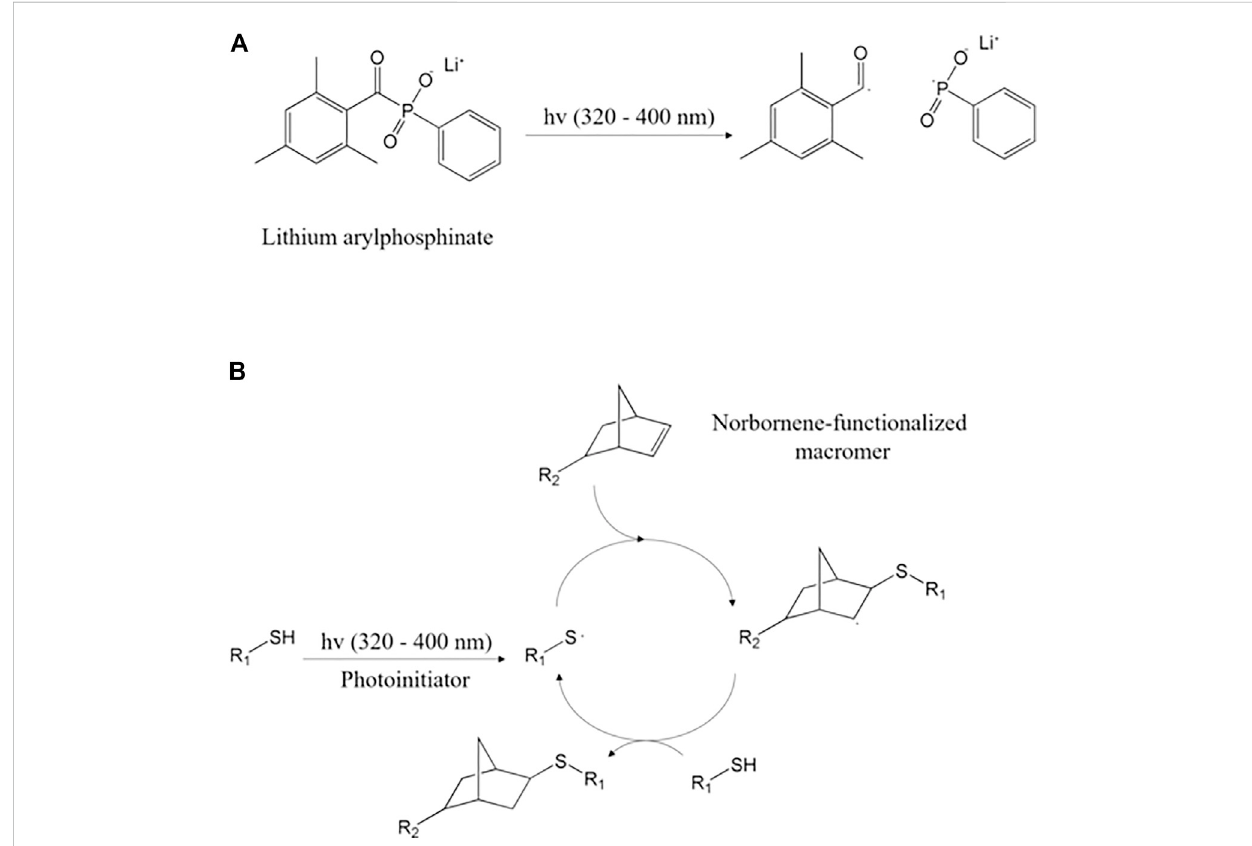
FIGURE 6 (A) LAP decomposition by UV and (B) thiol – norbornene photo-click reaction step with a thiol – containing molecule (R1 – SH) (Lin et al.,